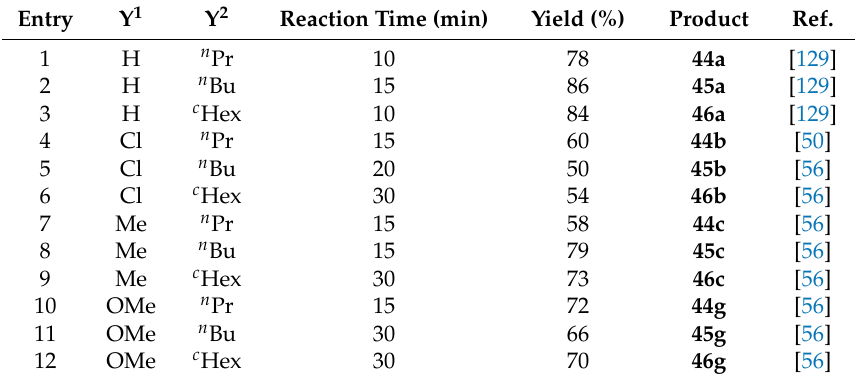
Table 3. Details of the synthesis of α -aminophosphonates 44 – 46 from α -hydroxyphosphonates 1B . Entry Y 1 Y 2 Reaction Time (min) Yield